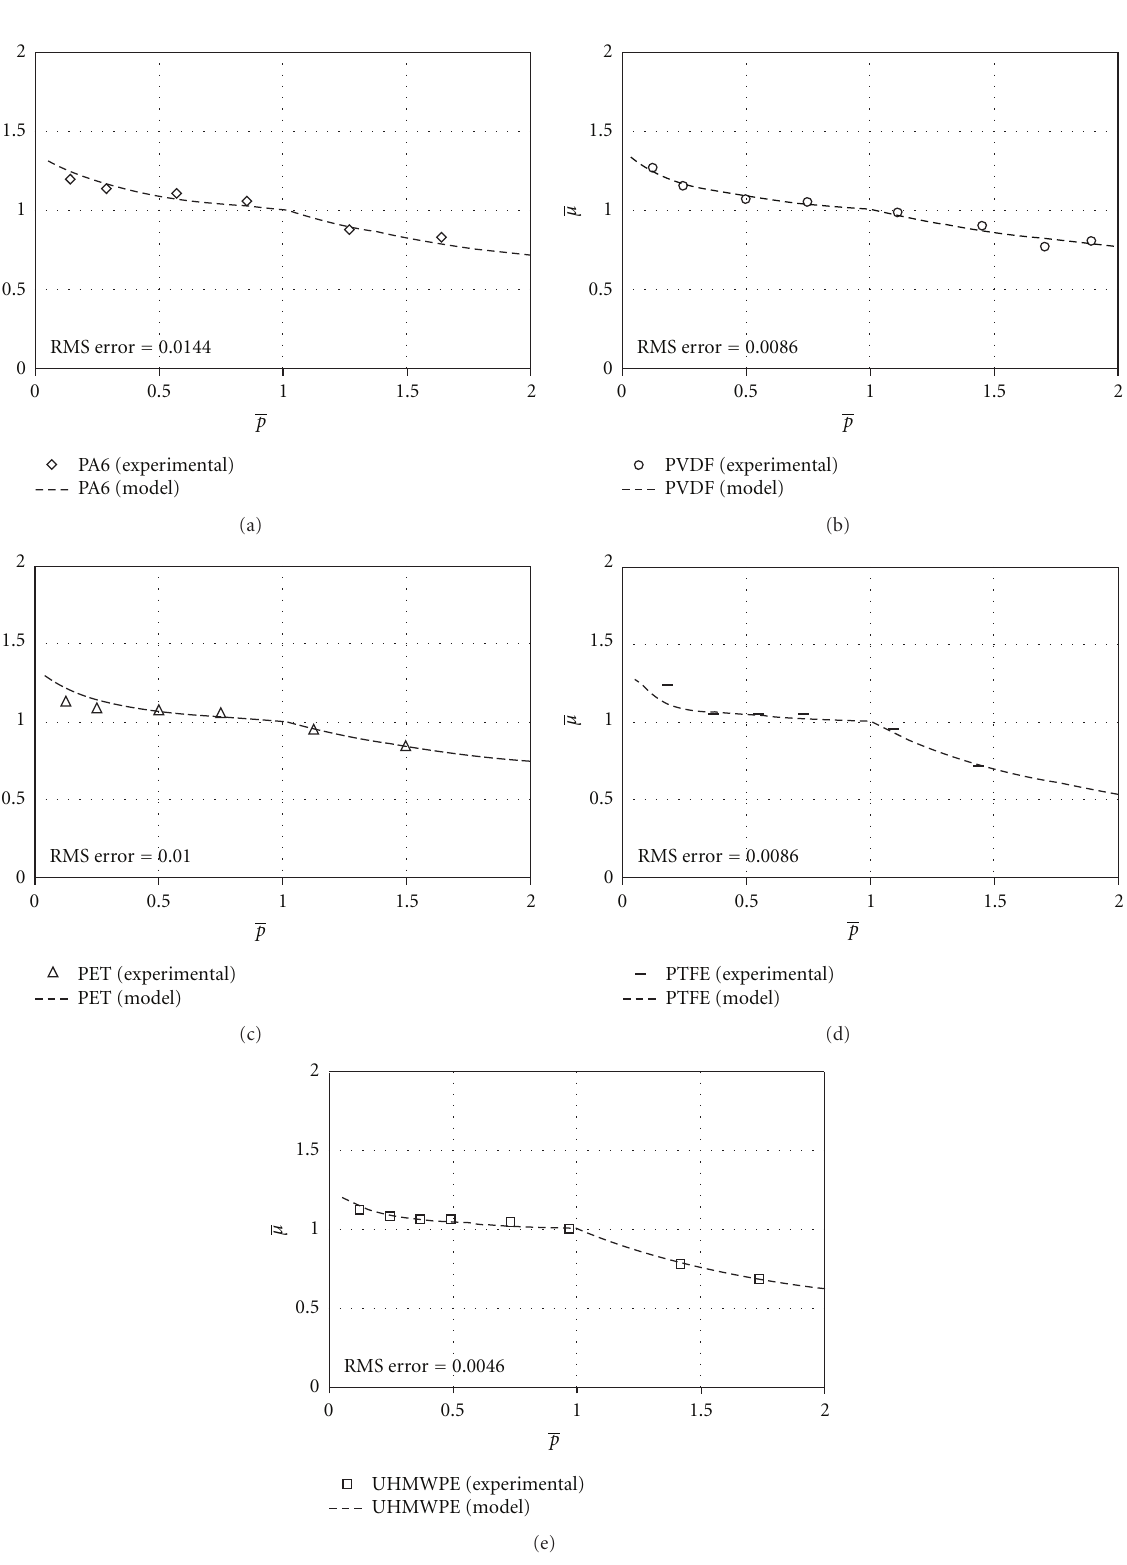
Figure 4: Curve fitting of experimental friction curves by the friction law of (10) with respect to dimensionless variables p and μ defined in (9) and relevant root mean square (RMS) error. Model parameters are given in Table